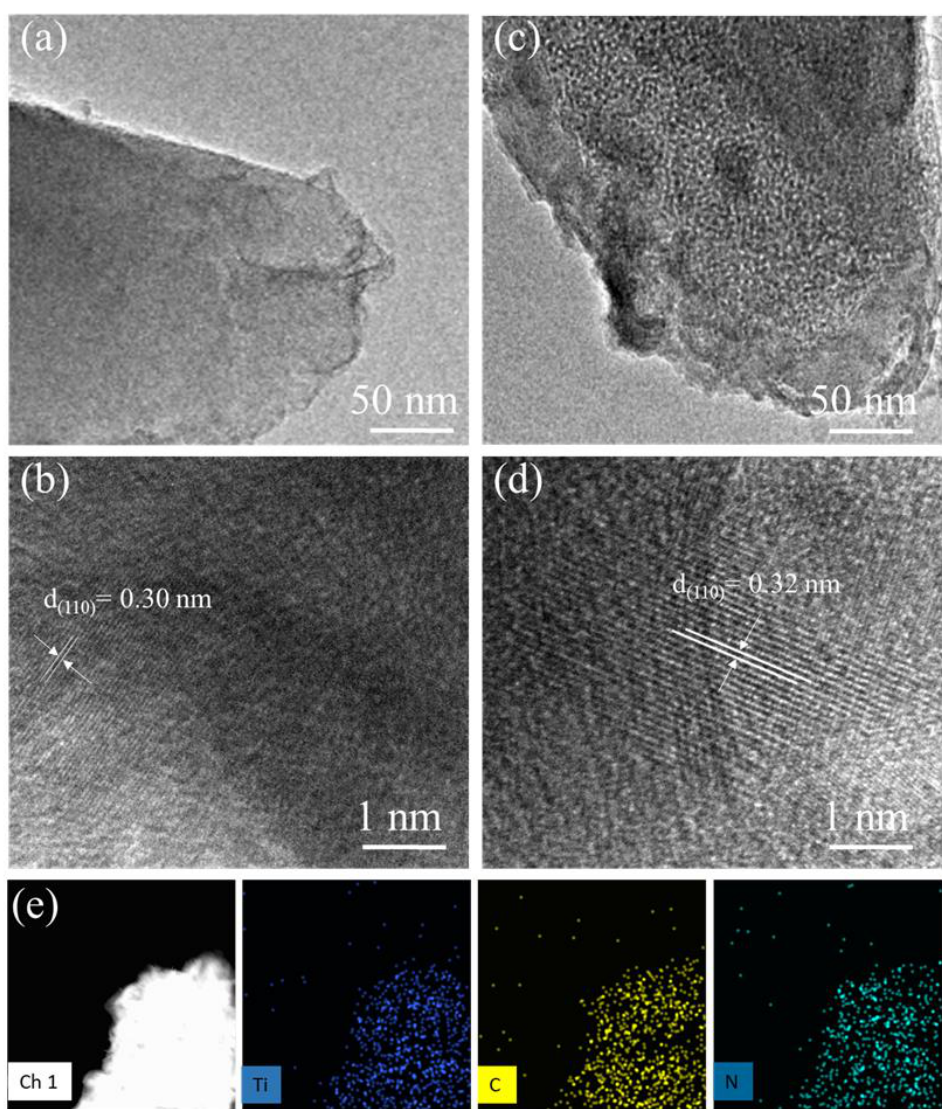
Figure 2. Low-resolution TEM images of ( a ) Ti 3 C 2 T x -MXene and ( b ) N -Ti 3 C 2 T x ; high resolution TEM images of ( c ) Ti 3 C 2 T x -MXene and ( d ) N -Ti 3 C 2 T x ; and ( e ) EDS elemental mapping. Figure 3a,b depict X-ray diffraction (XRD) images of Ti 3 C 2 T x -MXene and N -Ti 3 C 2 T x - MXene. Ti 3 C 2 T x -MXene ’s XRD pattern has a characteristic peak less than 10°, which con- firms that Ti 3 AlC 2 was successfully etched to fabricate Ti 3 C 2 T x -MXene [34]. XRD images of N -Ti 3 C 2 T x -MXene show that the N -functionalization approach had minimal effect on Ti 3 C 2 T x -MXene ’s phase structure; the only notable change was that the (002) peak moved toward a lower diffraction angle associated with increased spacing. After further exami- nation, it was discovered that the (002) peak was situated at approximately 9.3°, which was associated with a 0.96 nm interlayer spacing. Following N -functionalization, the po- sition of the (002) peak changed to 8.9°, and the interlayer spacing was modified to 0.99 nm (Figure 3b). Increased interlayer spacing might have efficiently exploited the potential area for Zn 2+ accommodation, implying a high capacitance. Further, Figure 3c shows high resolution Ti-2p XPS spectra, which were deconvoluted into five components: Ti-C (454.65 eV), Ti 2+ -C (456.05 eV), Ti 3+ -C (458.35 eV), TiO 2 (460.74 eV), and Ti 4+ -C (464.21 eV). After N - functionalization, a new peak appeared at Ti 4+ -C (464.21 eV). Notably, each peak’s inten- sity was enhanced after N -functionalization, suggesting that Ti 3 C 2 T x -MXene underwent partial oxidation during the N -functionalization process. N -Ti 3 C 2 T x - MXene’s deconvo- luted N -1s XPS spectra are shown in Figure 3d, which shows peaks at 399.30 eV corre- sponding to pyrrolic-N, whereas the peak at a 401.33 eV binding energy corresponds to